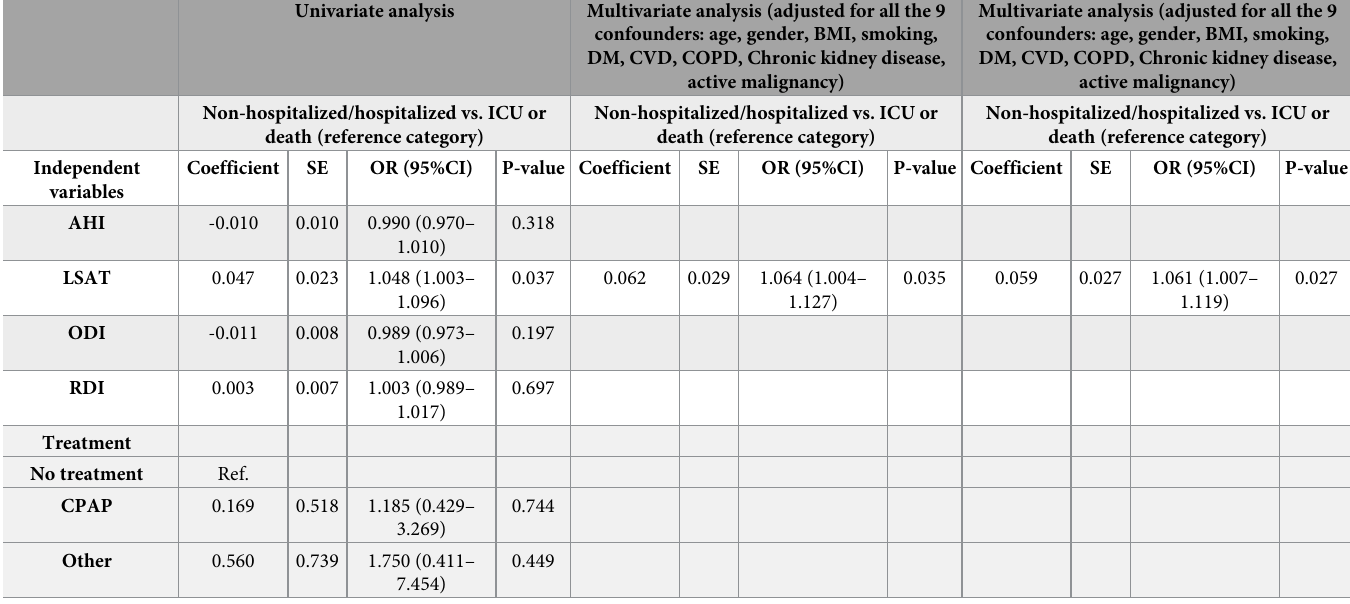
Table 4. Binary logistic regression analysis for COVID-19 severity when COVID-19 severity was dichotomized as non-hospitalized or hospitalized and ICU or